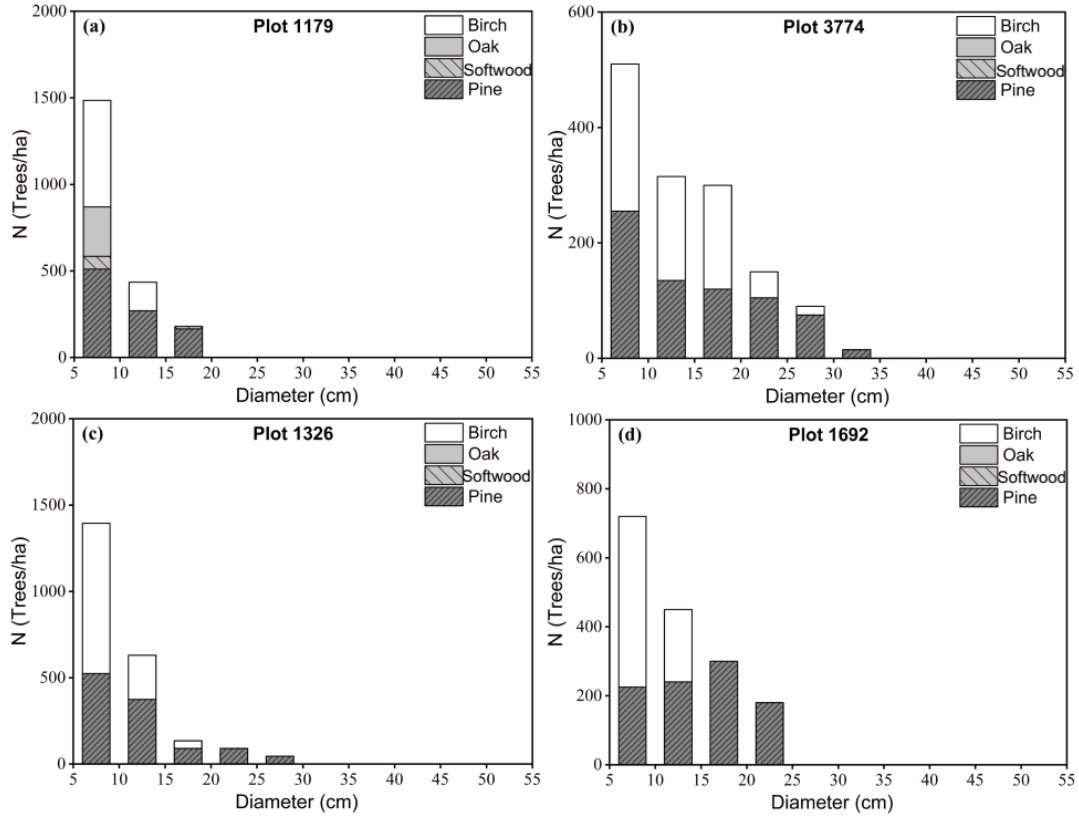
Figure 4. Diameter distribution of NFI plot numbers 1179, 3774, 1326, and 1692 by species group and diameter class.